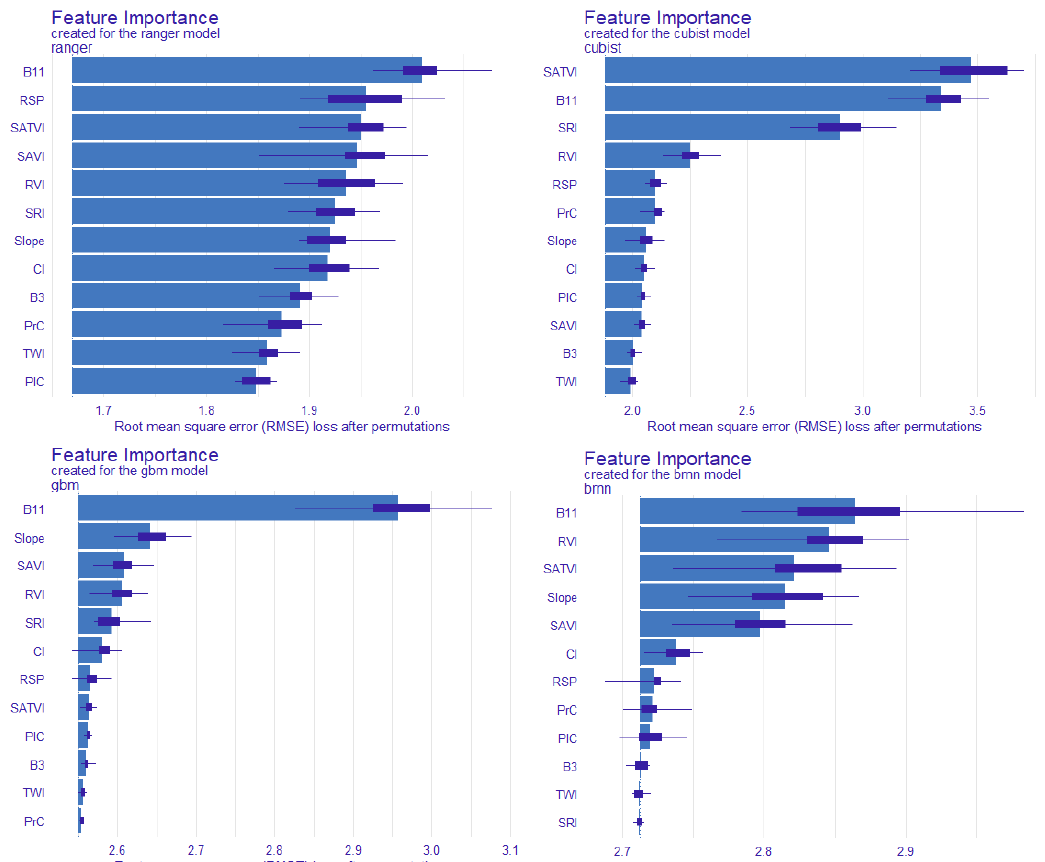
Figure 7. Permutation base on variable importance measures for the explanatory variables. Notes: the box plot indicates the error values of 10 permutations, and the height of bars indicates the mean error values of 10 permutations.